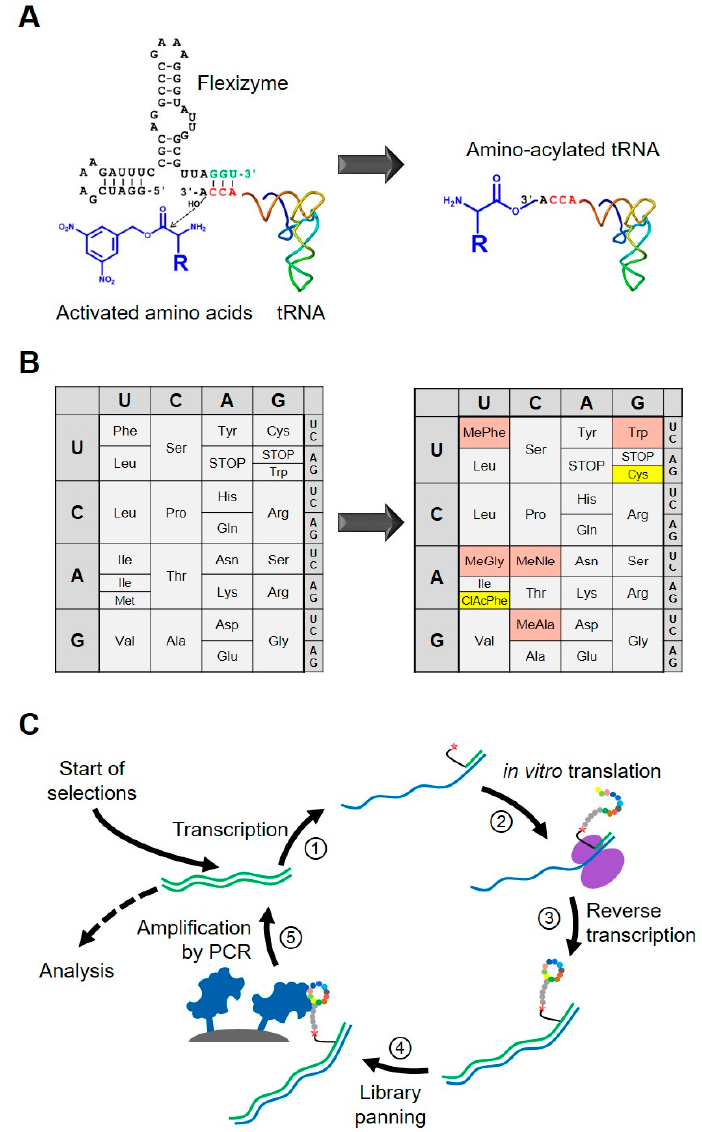
Figure 3. Cornerstones of the PDP technology: ( A ) Flexizyme catalyzes charging of tRNAs with a variety of natural and non-natural amino acids with an active ester at their carboxyl group. ( B ) Tailored in vivo translation systems (e.g. PURE) allows the reprogramming of genetic code. In the current example, the following non-natural amino acids are introduced: N -chloracetyl-phenylalanine (ClAcPhe) serving for the thioether based cyclization; N -methylalanine (MeAla), N -methylglycine (MeGly), N -methylnorleucine (MeNle) and N -methylphenylalanine (MePhe). ( C ) mRNA display based iterative selection process starts from the transcription of the DNA libraries into mRNA ① and its translation into the peptide and attachment to the mRNA through a puromycin based linker ②. The thioether bridge forms between the N-terminal ClAcPhe and C-terminal cysteine residue of the translated peptide. ③ Reverse transcription of the mRNA results in a more stable RNA/DNA hybrid tag and prevents RNA aptamer formation. ④ Panning of the peptide with the RNA/DNA tag on the immobilized tag enriches binding sequences. ⑤ Elution and amplification of the DNA tag yields the starting point for the next selection round. After completion of multiple selection rounds a comprehensive hit list is obtained by NGS for all rounds. Components are not drawn to scale.